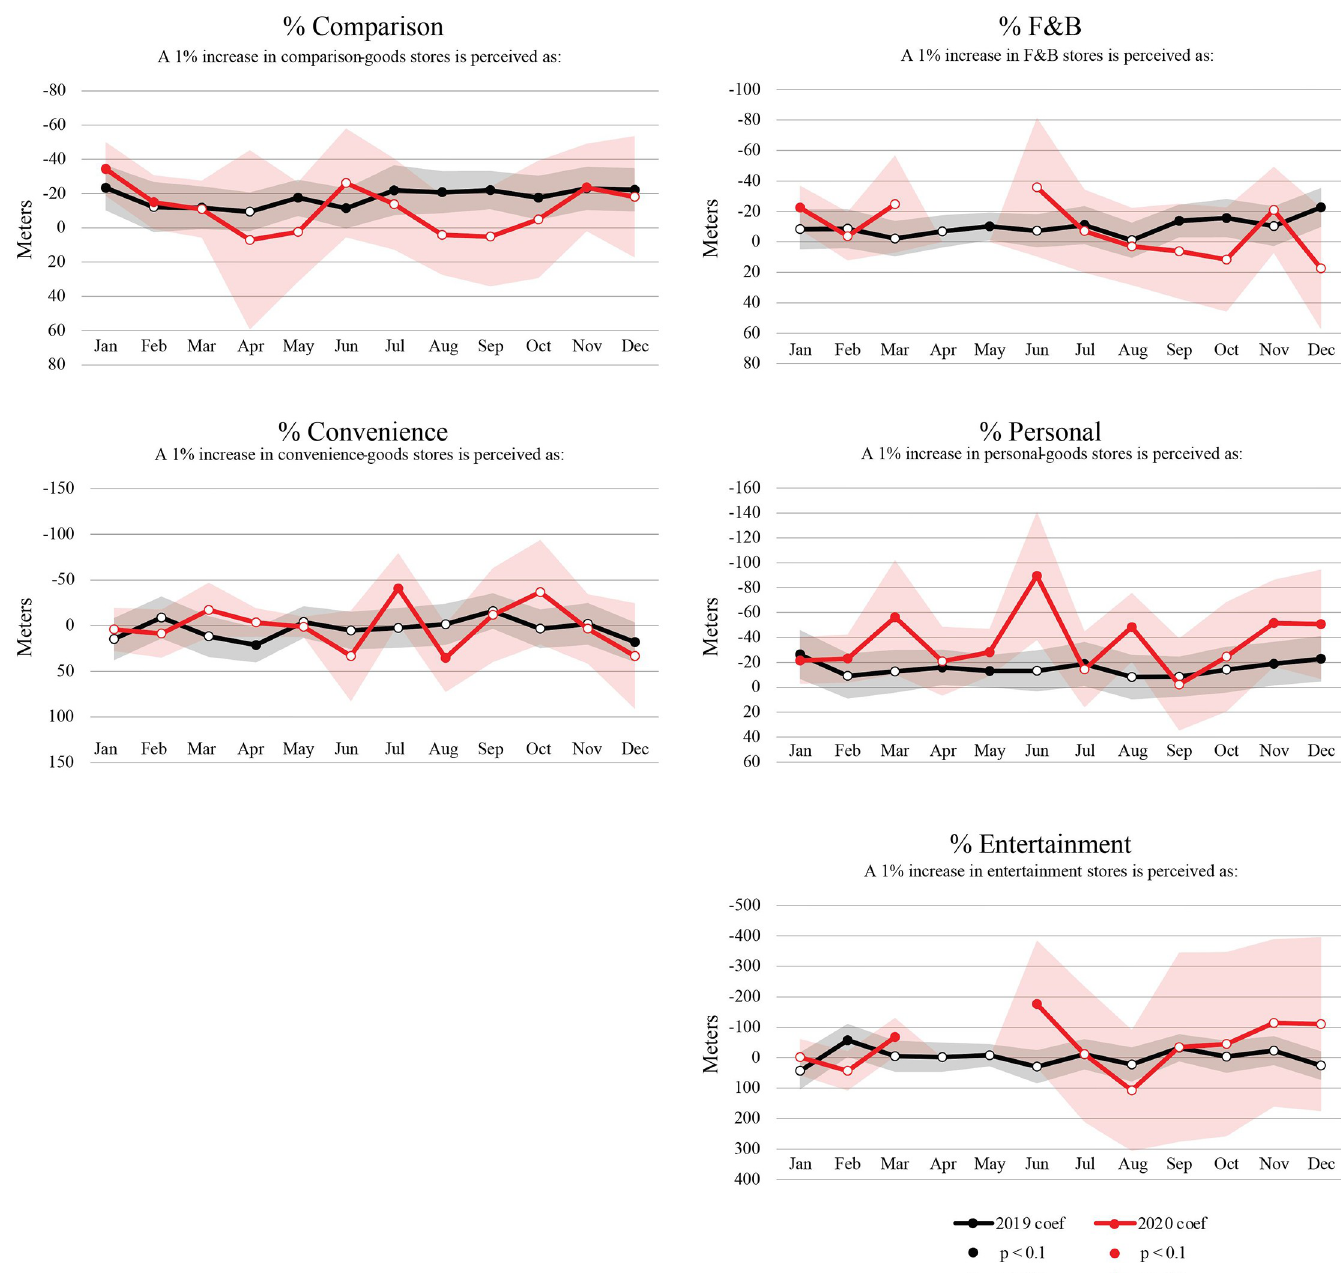
Fig 7. Estimated preferences towards cluster business composition. Trend lines represent distance-equivalent coefficients (ratio between coefficient and distance coefficient).